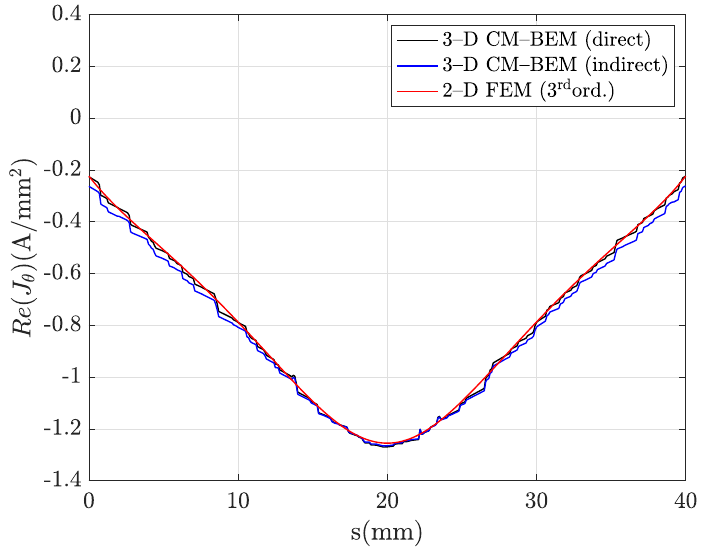
Figure 4. Real part of the azimuthal current density component along line A-B (black line: direct formulation, blue line: indirect formulation, red line: 2D FEM, taken as a